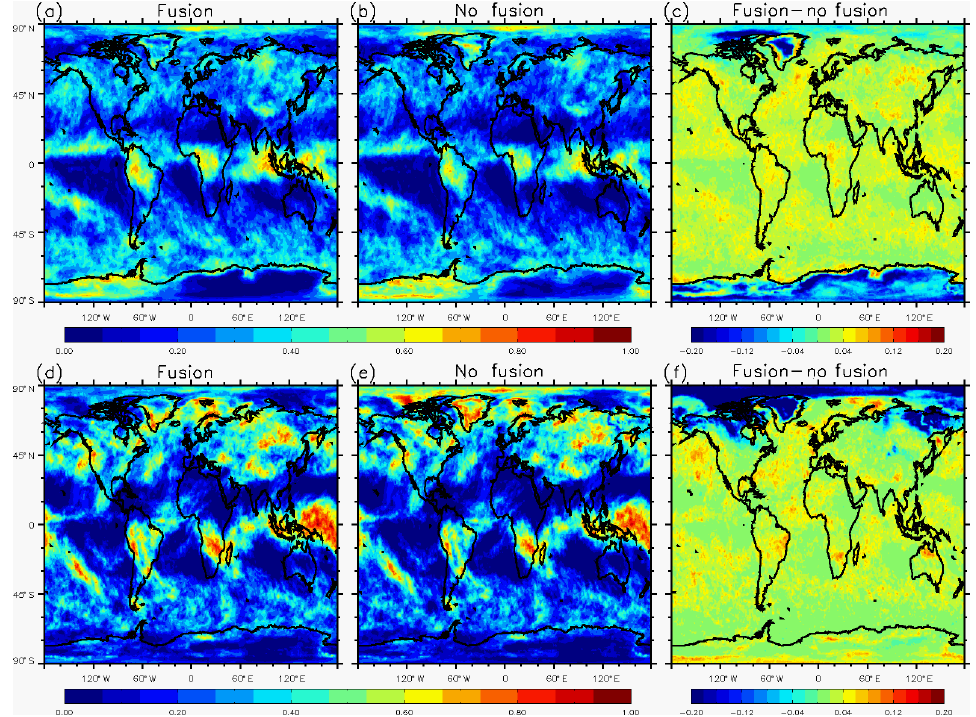
Figure 2. Mean gridded ice cloud fraction with fusion channels (a, d) , without fusion channels (b, e) , and differences between fusion and no fusion (c, f) . The upper row shows S-NPP and lower row shows